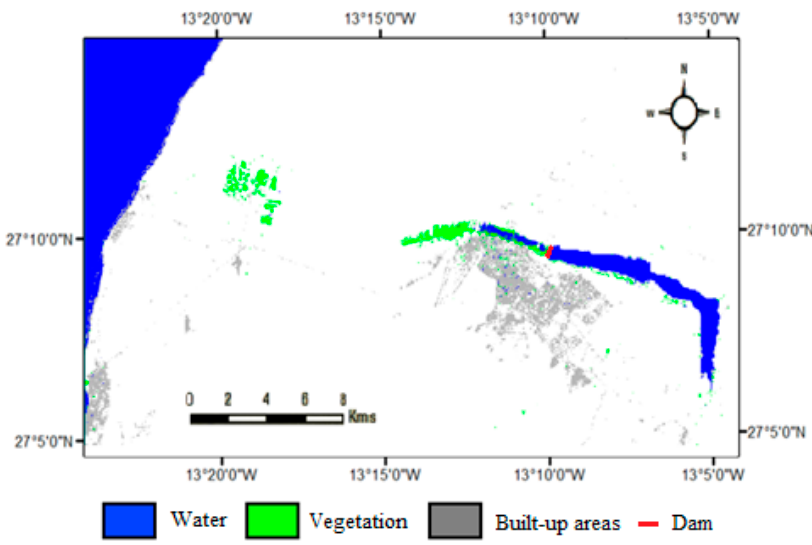
Figure 15. SVM classifier’s results for the date before the event (20 October 2016).